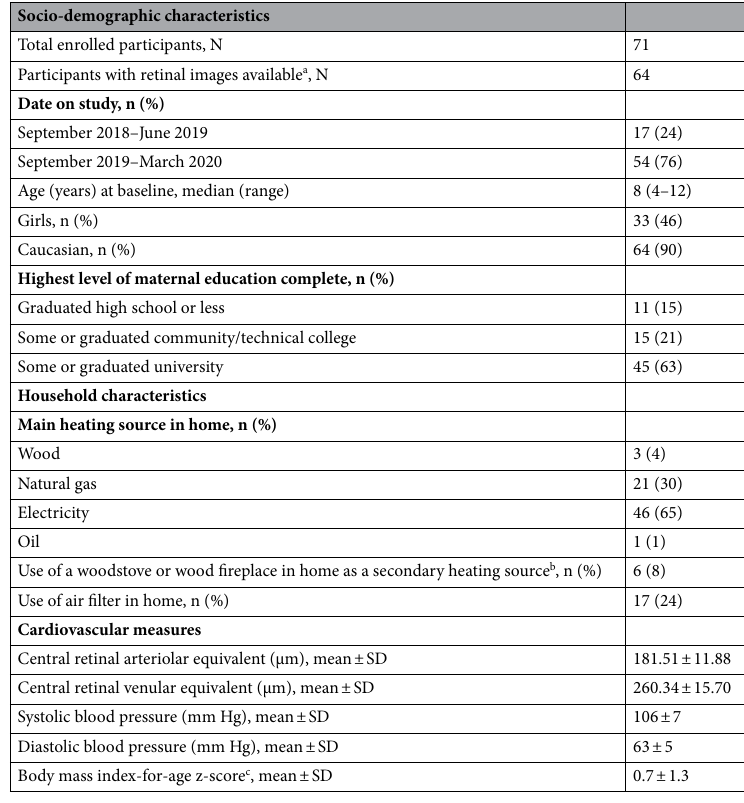
Table 1. Description of the study population. a High-quality images were unavailable for some participants due to blinking, inability to sit still, and general discomfort with getting their eyes photographed. b Excludes participants in which a woodstove/wood fireplace is the main source of heating. c Body mass index-for-age- and-sex z-score calculated based on World Health Organization growth